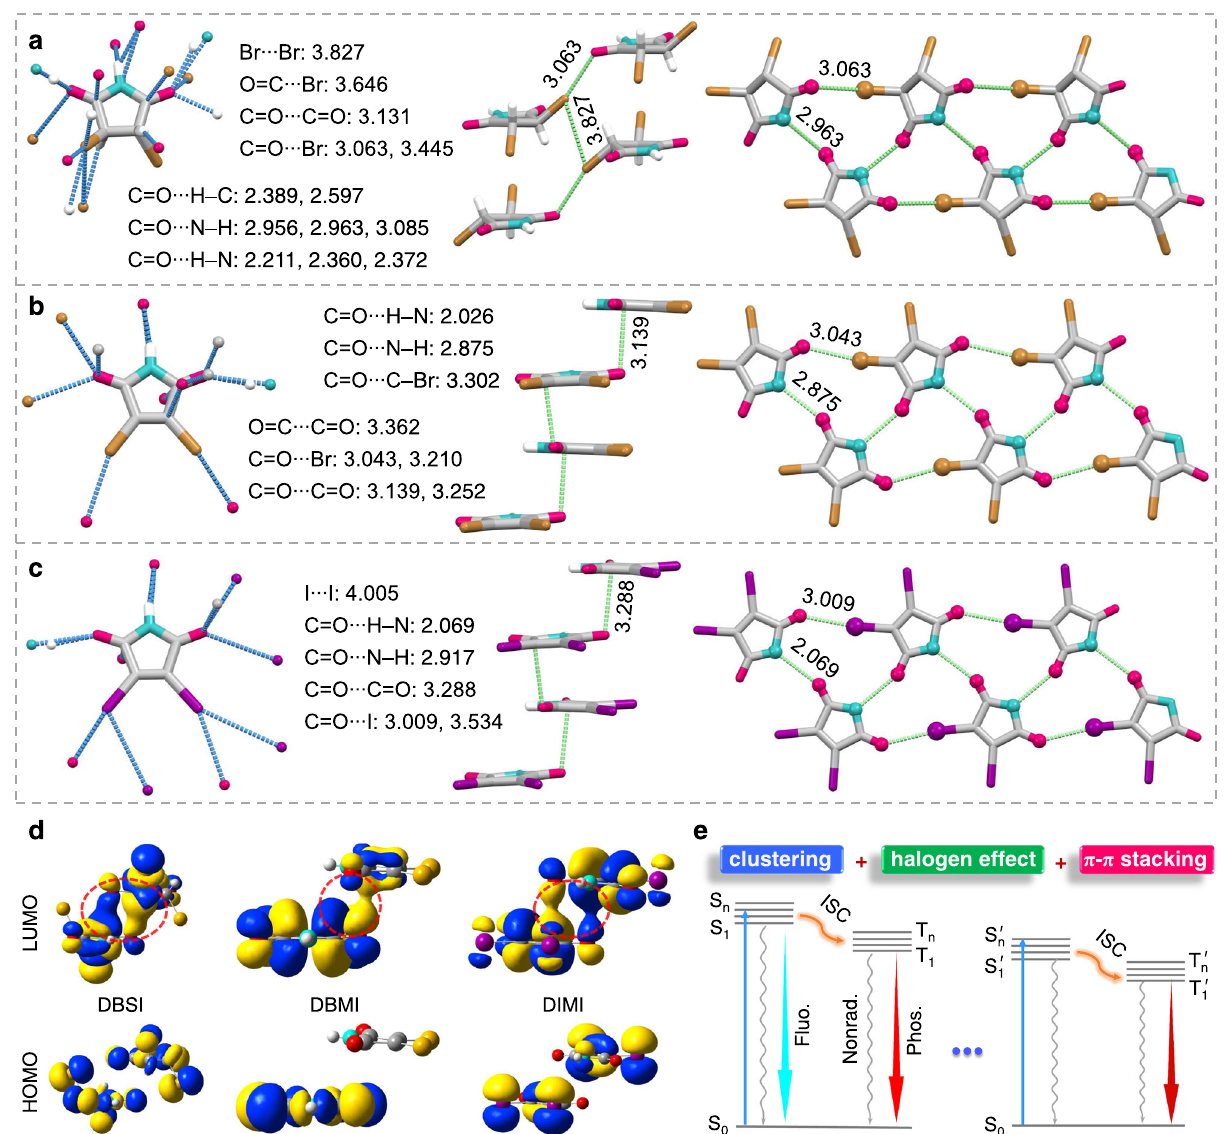
Fig. 3 Single-crystal structures, HOMO/LUMO electron densities, and luminescent mechanism of DBSI, DBMI, and DIMI. a – c Single-crystal structure with denoted intermolecular interactions and fragmental molecular packing with denoted short contacts among electron-rich units of a DBSI, b DBMI, and c DIMI. d HOMO and LUMO electron densities of the selected dimers of DBSI, DBMI, and DIMI. e Demonstration of the luminescent mechanism and the generation of red/NIR RTP of the crystals. ISC, Fluo., Phos., and Nonrad. represent intersystem crossing, fl uorescence, phosphorescence, and nonradiative transitions,